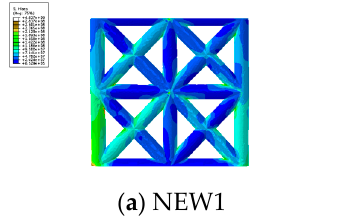
Figure 16. Mises stress of the wall.